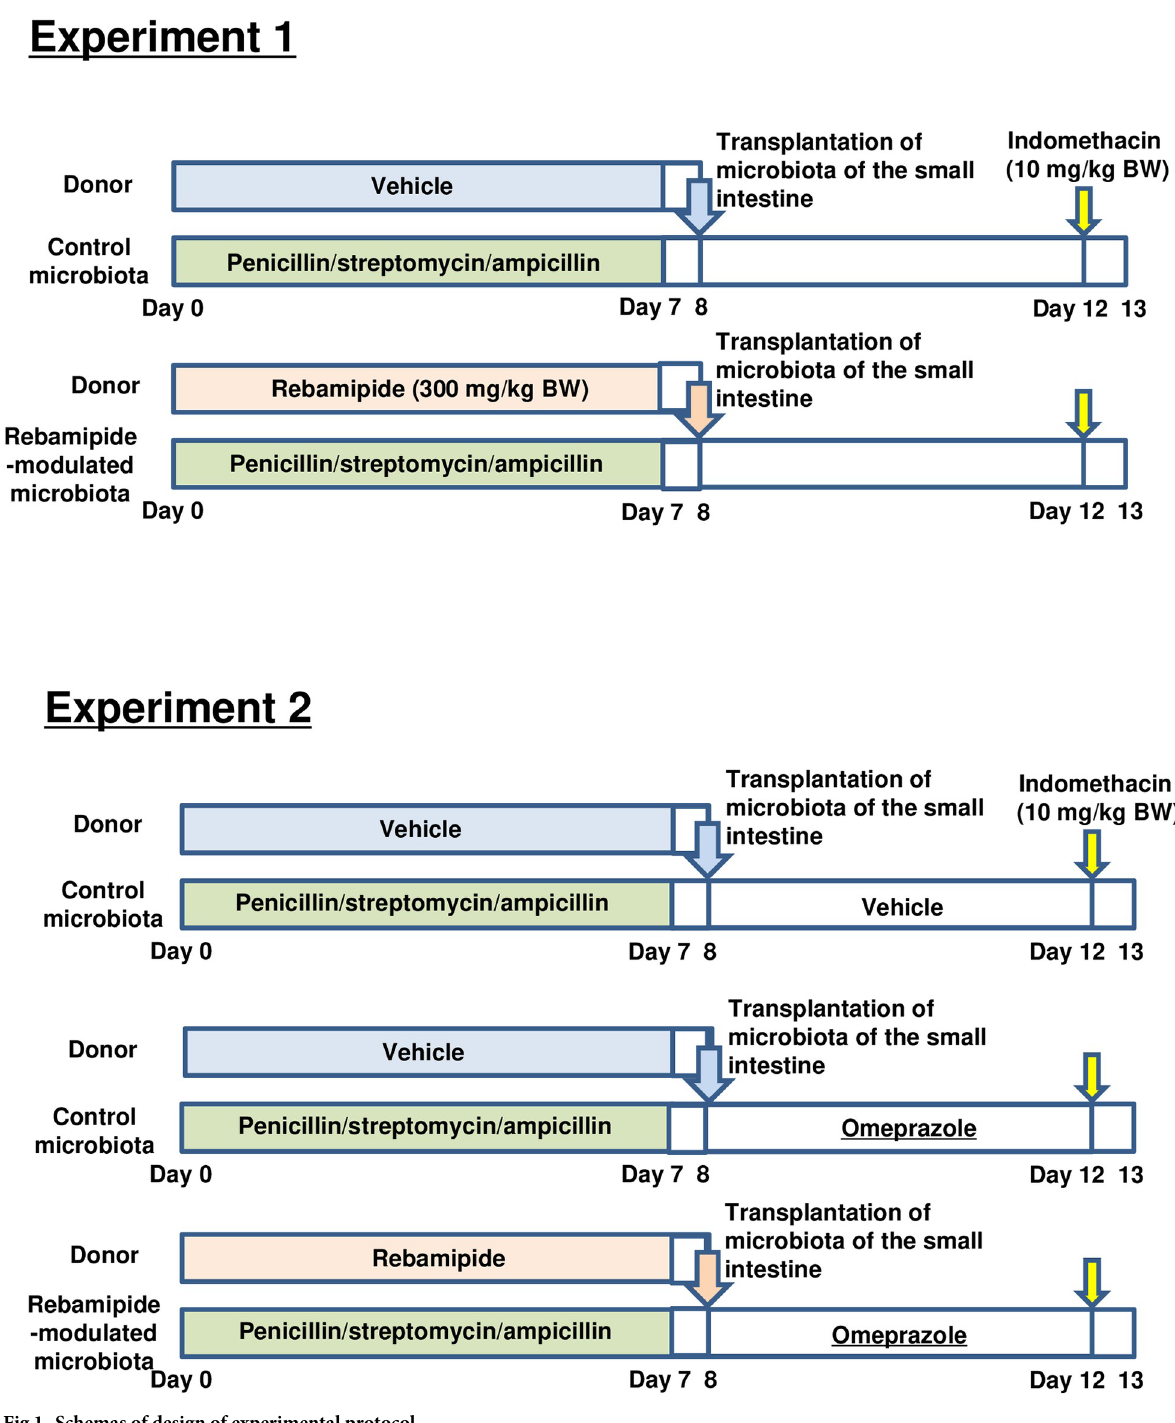
Fig 1. Schemas of design of experimental